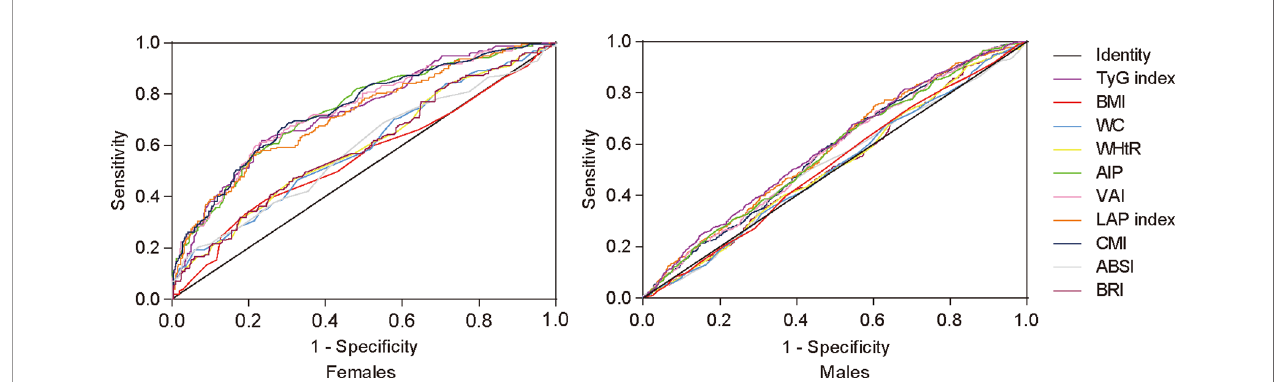
FIGURE 1 | Receiver operating characteristic curve analysis by sex. TyG index, triglyceride glucose index; BMI, body mass index; WC, waist circumference; WHtR, waist-to-height ratio; AIP, atherogenic index of plasma; CMI, cardiometabolic index; VAI, visceral adiposity index; LAP index, lipid accumulation product index; ABSI, a body shape index; BRI, body